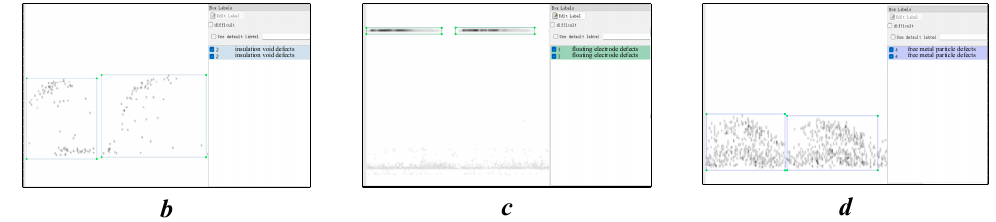
Figure 9. Sample markers of PD defects maps. ( a ) metal tip defects ( b ) insulating void defects, ( c ) floating electrode defects. ( d ) free metal particle defects. Table 2. Parameters for model training.